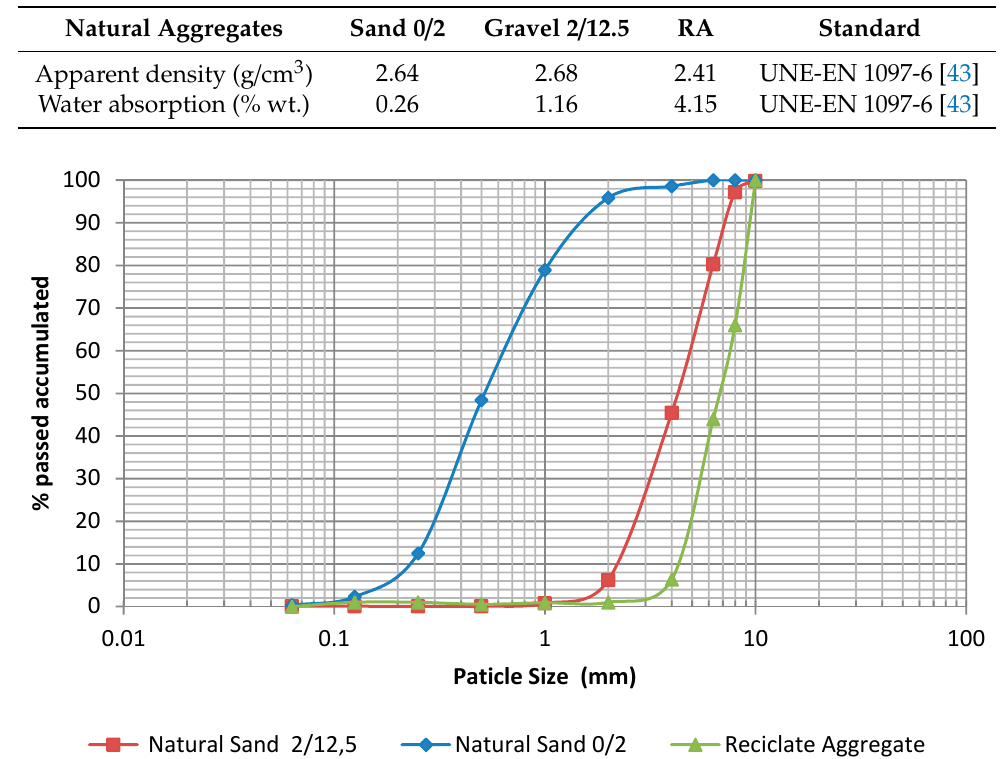
Figure 4. Grading curves of silica sands and RA.